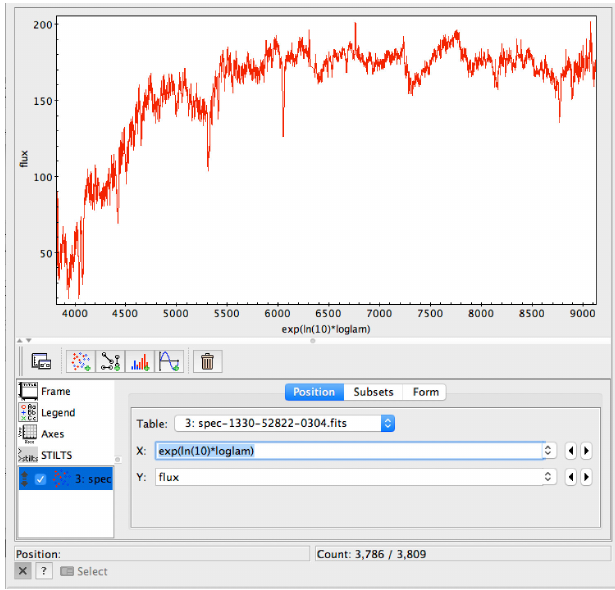
Fig. 78.— A quick look at an SDSS spectrum, with linear wave- lengths shown, using Plane Plot